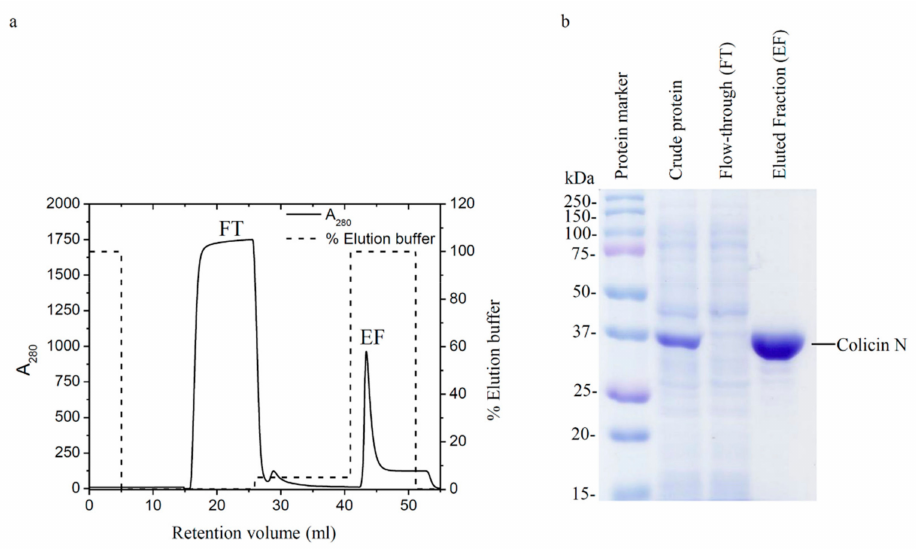
Figure 1. Purification of colicin N ( a ) Elution profile (black line) of colicin N using a nickel-sepharose HisTrap ™ HP a ffi nity column pre-equilibrated with a binding bu ff er (50 mM sodium phosphate bu ff er; pH 8.0, 300 mM NaCl and 10 mM imidazole). A 100% of elution bu ff er (50 mM sodium phosphate bu ff er, pH 8.0, 300 mM NaCl and 250 mM imidazole) was applied to the column for eluting colicin N. The percentage of elution bu ff er is shown as a dash line. ( b ) SDS-PAGE of crude protein and protein-containing fractions taken from the column. The band corresponding to colicin N shows at ~40